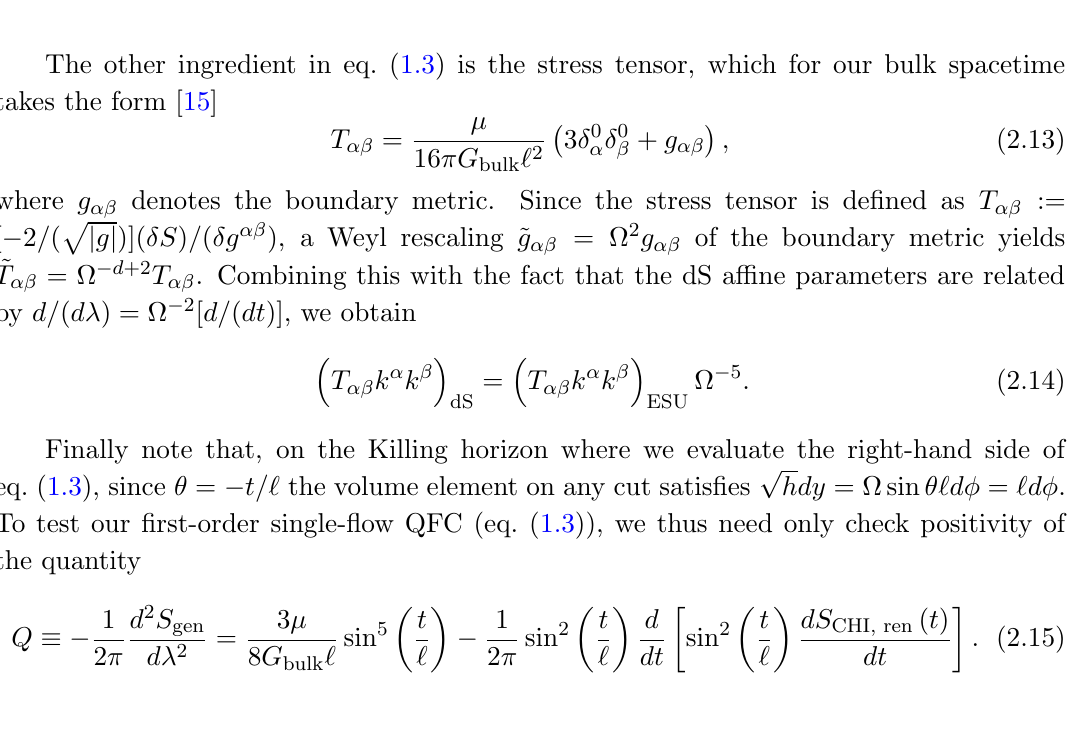
Figure 1 . Our surfaces C ( R ) projected onto a common constant-time hypersurface and drawn by taking standard polar coordinates (cid:26); (cid:18) on the plane to represent (cid:26) (cid:17) arctan( r=‘ ) and (cid:18) in AdS 4 - Schwarzschild. The azimuthal (cid:30) is suppressed. The outer circle denotes the boundary, the inner circle is the horizon, and the point p + is located on the right hand side of the diagram. The surfaces do not penetrate the interior of the black hole. At some (cid:12)nite time t = t (cid:3) , the causal surface forms a cusp and disconnects. In the (cid:12)gure we have chosen r EH =‘ = 1 = 5, for which t (cid:3) (cid:25) (cid:0) 2 :